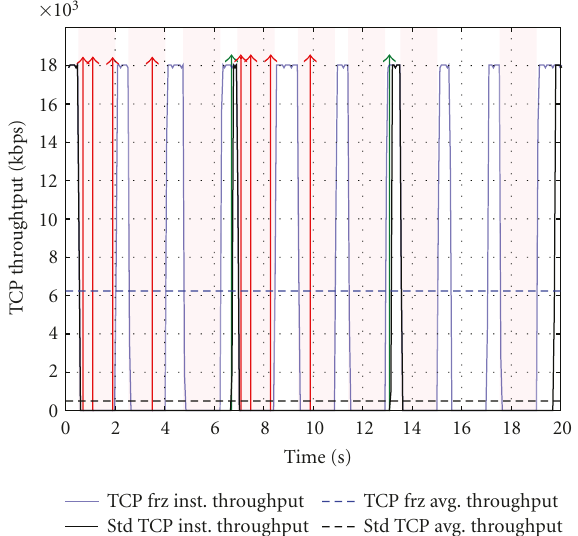
Figure 5: E ff ect of the lion attack on TCP throughput freezing and nonfreezing TCP